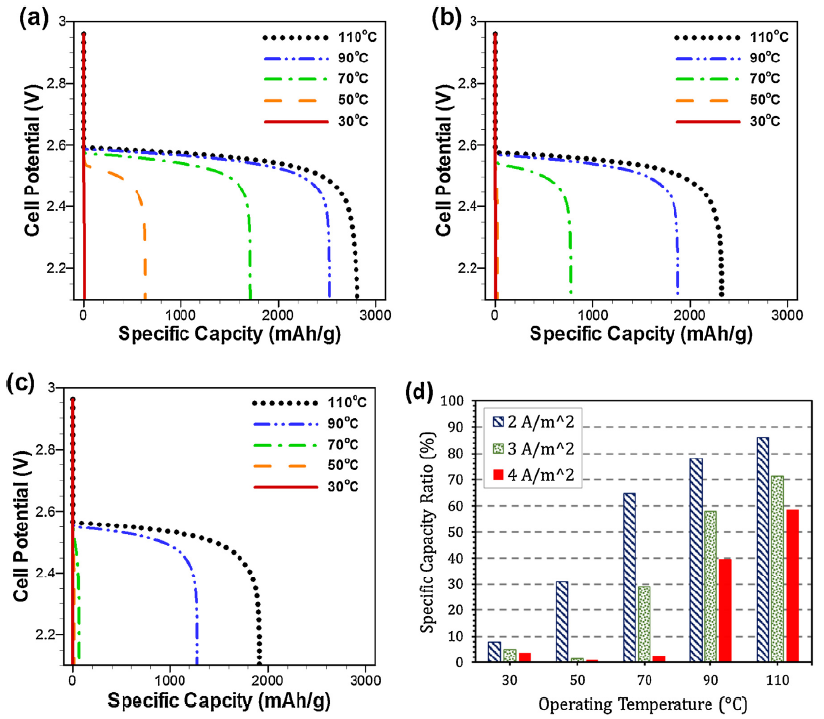
Figure 31. Electrical performance of a Li-air cell during discharge for an applied load current density of ( a ) 2 A/m 2 ; ( b ) 3 A/m 2 ; and ( c ) 4 A/m 2 ; ( d ) Maximum specific capacity ratio with respect to maximum specific capacity at 1 A/m 2 for various load current conditions is shown. Adapted with copyright permission from Yoo et al. [44], with permission from Elsevier.